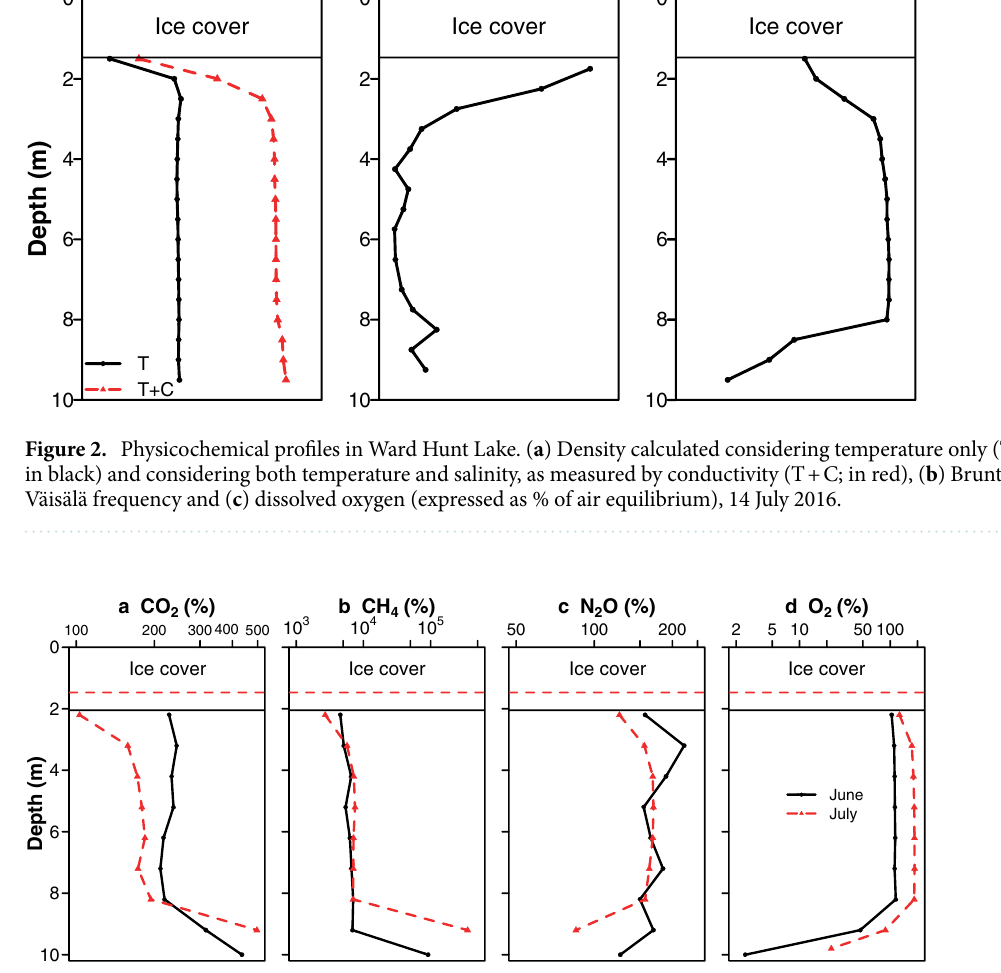
Figure 3. Concentrations of dissolved gases in Ward Hunt Lake on 7 June and 16 July 2017. ( a ) carbon dioxide (CO 2 ), ( b ) methane (CH 4 ), ( c ) nitrous oxide (N 2 O) and ( d ) oxygen (O 2 ) expressed as % equilibrium with air, in Ward Hunt Lake in June (black) and July (red) 2017. Note the differences in logarithmic